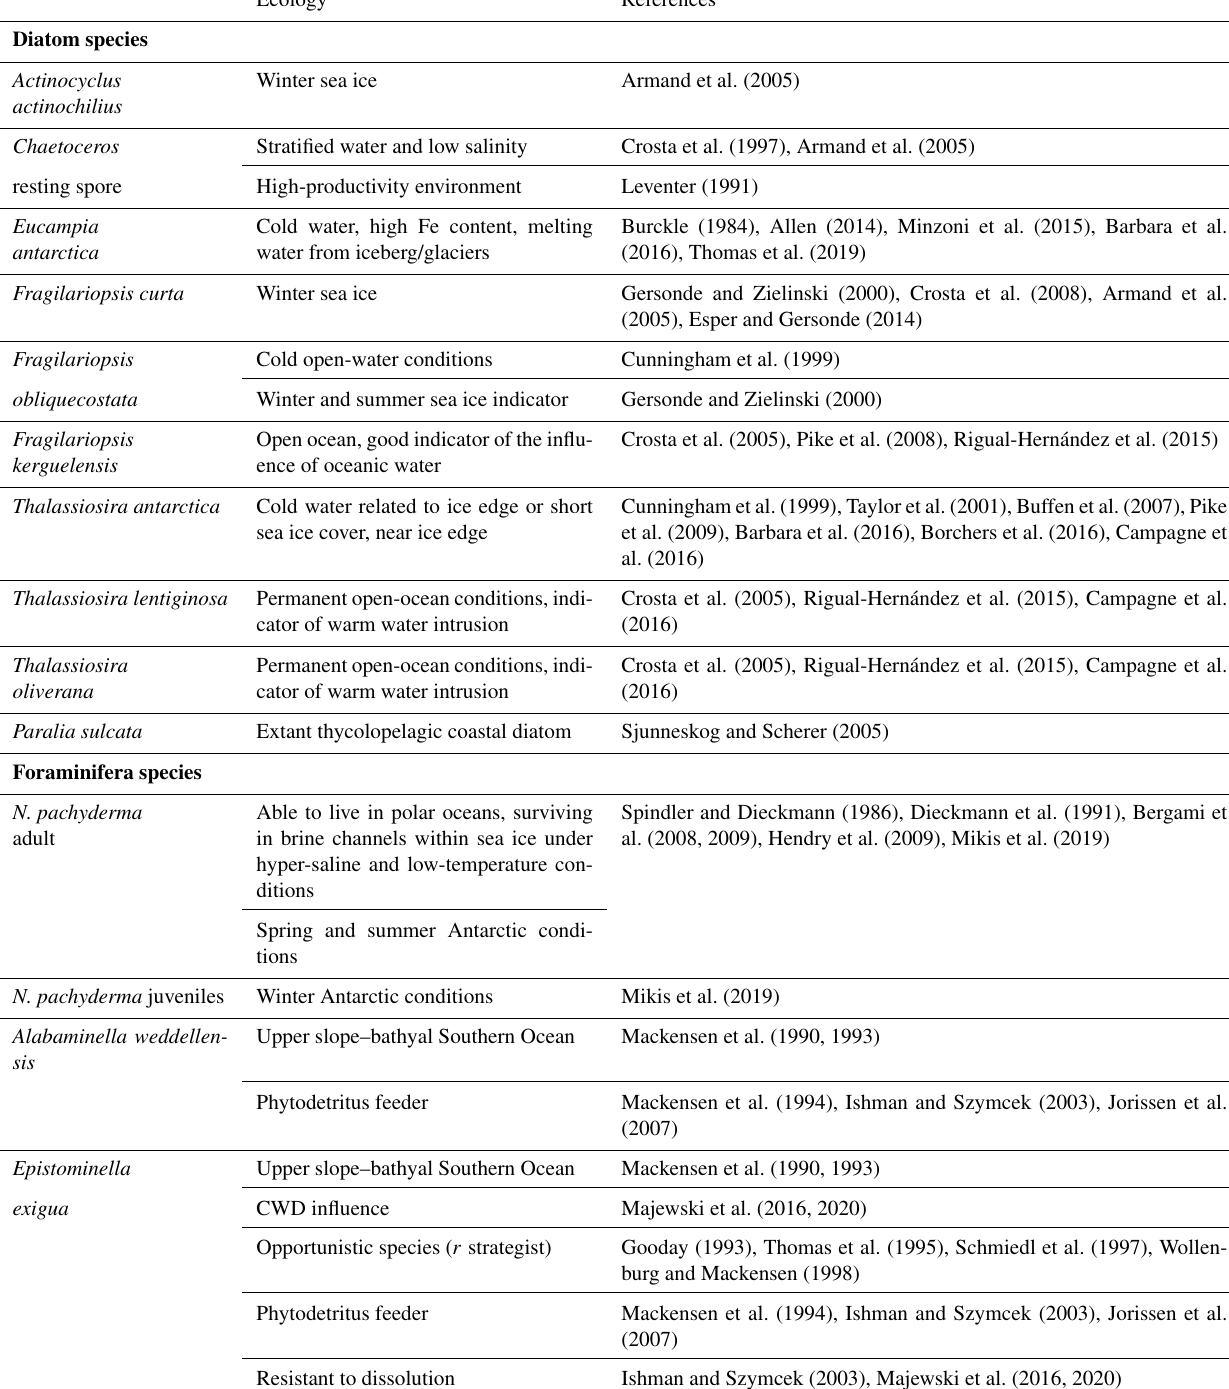
Table 2. Taxonomy and ecology of the most abundant diatoms, silicoflagellates, and planktic and benthic foraminiferal species identified in the studied